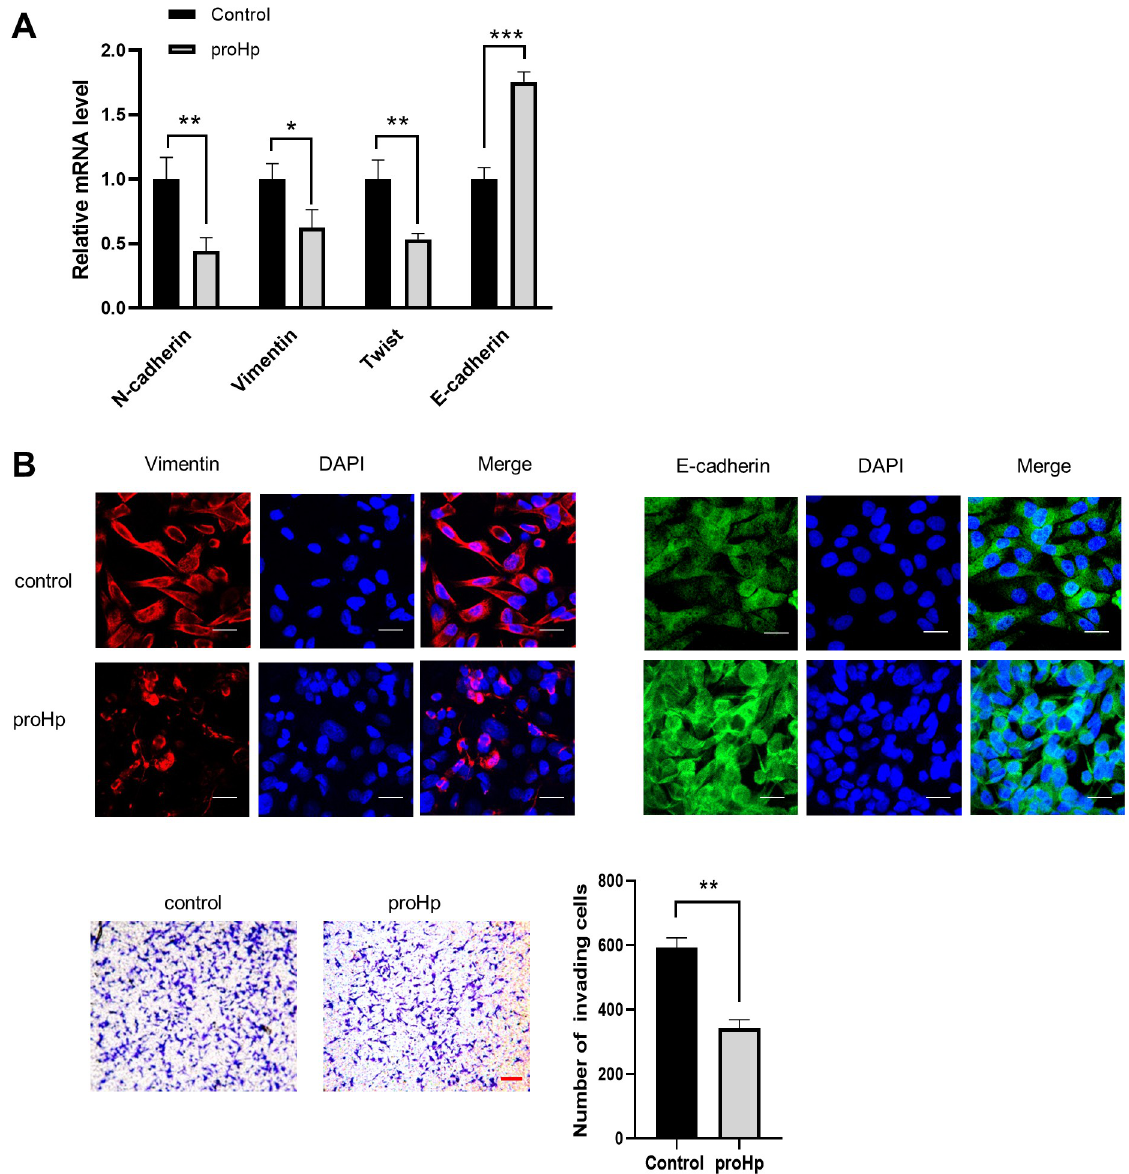
Fig 2. proHp overexpression reduces mesenchymal properties and invasion of SK-Hep1 cells. proHp-overexpressing cells transfected with the Hp gene and control cells transfected with vehicle vector DNA were cultured for 48 h in DMEM containing 10% FBS. (A) mRNA levels of N-cadherin, vimentin, twist, and E-cadherin were determined by qRT-PCR. The expression levels were normalized to GAPDH. Data are presented as the mean ± SD of triplicate experiments. � P < 0.05, �� P < 0.01, ��� P < 0.001 vs. vector-transfected control cells (Student’s t-test). (B) Immunofluorescence staining of vimentin and E-cadherin in control and proHp-overexpressing cells was detected by confocal microscopy (scale bar = 25 μ m). Results are representative of independent experiments repeated twice. (C) Cell invasion was evaluated by a transwell assay. Cells in serum-free medium were added to the upper chamber and 10% FBS-containing DMEM was added to the lower chamber. After incubation for 24 h, invading cells were stained, photographed under an inverted microscope (scale bar = 100 μ m), and counted in three randomly selected fields per group. Results are representative of three independently performed experiments. �� P < 0.01 vs. vector-transfected control cells (Student’s t-test).